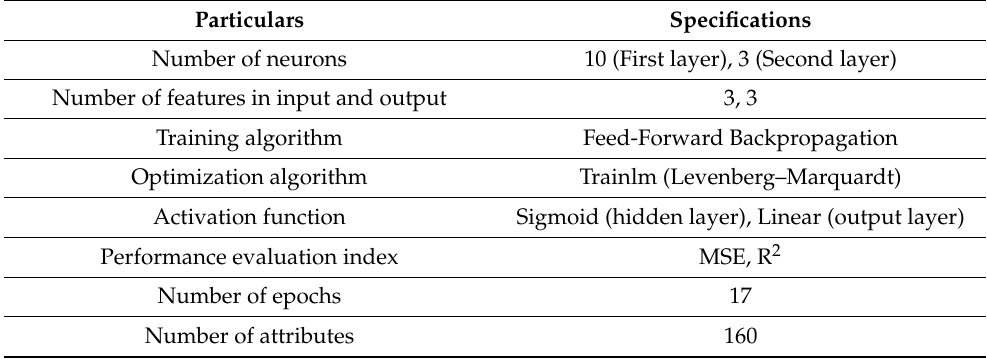
Table 2. Overview of Proposed ANN model. Particulars